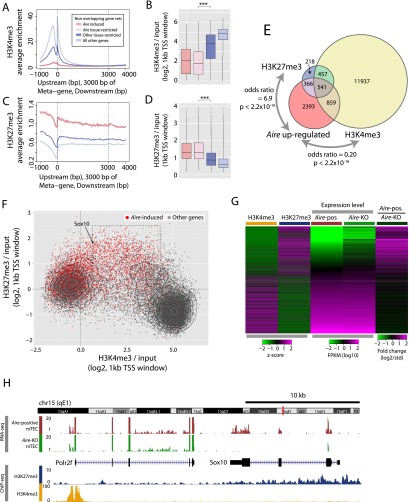
Aire expression is associated with transcription of Polycomb silenced genes in mTEC. (A) Metagene profiles of the average normalized enrichment of H3K4me3 against input for sets of genes distinguished by Aire dependence and tissue specificity. (B) Boxplots of the median enrichment of H3K4me3 at the TSS of these sets of genes. (C,D) The results of the corresponding analysis for H3K27me3 marks. In B and D, *** indicates a significance level of P < 0.001 using the Mann-Whitney U-test. (E) The association of genes up-regulated by Aire expression (>2×, FDR < 0.05, Aire-positive vs. Aire-knockout mTEC) with genes whose TSS (1-kb centered windows) showed an average (n = 2) twofold or greater enrichment for H3K27me3 or H3K4me3 marks over input. Stated P-values were calculated using Fisher’s exact test. (F) Enrichment of H3K4me3 and H3K27me3, respectively, for the TSS of all protein-coding genes. Those induced by Aire expression are highlighted in red. The dashed box highlights a subset of genes induced by Aire expression whose TSS show enrichments for both modifications. (G) Genes induced by Aire expression are generally weakly transcribed in Aire-KO mTEC and have relatively low H3K4me3 enrichment scores and relatively high H3K27me3 enrichment scores. The heatmap shows all genes ordered by their ratio of expression in mature Aire-positive and knockout TEC. (H) The chromatin state and expression of APS-1 autoantigen ortholog Sox10 and Polr2f encoding a RNA Pol II subunit in mature mTEC.